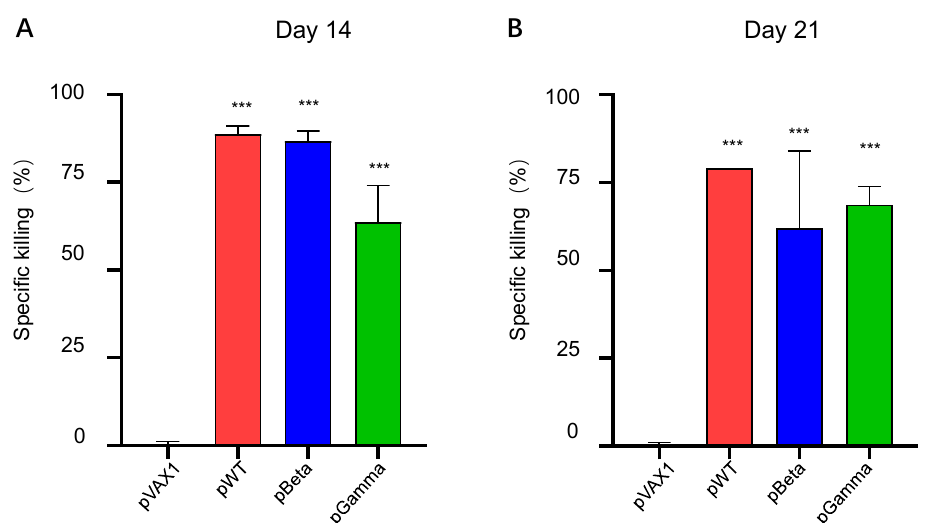
8 of 15 Figure 4. FACS analysis of splenocytes from mice immunized with various DNA vaccine constructs on day 21. ( A ) Gating strategy of CD4 and CD8 T cells from splenocytes, ( B ) representative data of IFN γ + CD4 + T cells, and ( C ) IFN γ + CD8 + T cells in spleens from mice immunized with the four DNA vaccine constructs: pVAX1, pWT, pBeta and pGamma. We finally observed whether such a strong cellular immune response was sufficient to have a cytotoxic function in vivo. An in vivo killing assay using eflour 450-labeled cells showed that all three DNA vaccines, pWT, pBeta, and pGamma, were able to generate a highly efficient specific killing activity of SARS-CoV-2 wild type. On day 14 post-immun-